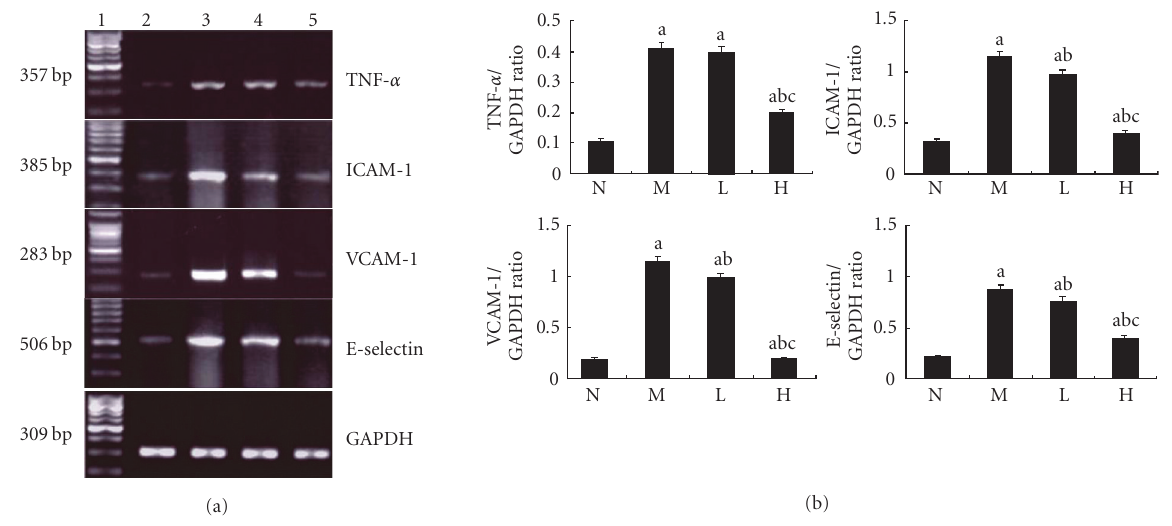
Figure 9: Expression of TNF- α , ICAM-1, VCAM-1, and E-selectin mRNA in rat liver using RT-PCR analysis. (a) Lane 1 represented 100 bp maker, lane 2 represented the normal control group (N); lane 3 represented the model group (M); lane 4 represented the group treated with low dose of thalidomide (L); lane 5 represented the group treated with high dose of thalidomide (H). GAPDH served as an internal control. (b) Comparison of the expression of TNF- α , ICAM-1, VCAM-1, and E-selectin mRNA using RT-PCR analysis. a P < . 01 versus normal control group; b P < . 01 versus model group; c P < . 01 group treated with high dose of thalidomide versus group treated with low dose of